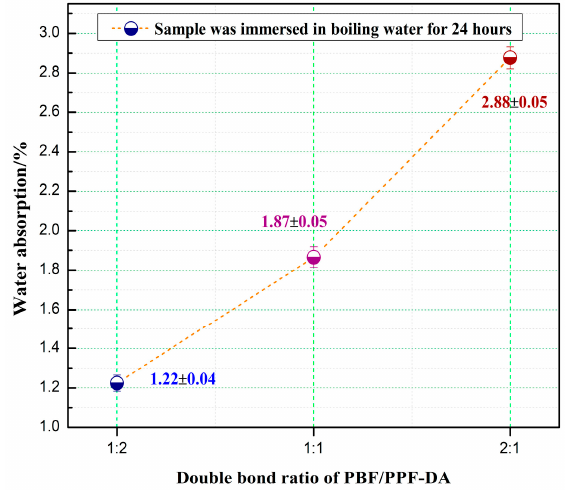
Figure 8. The water absorption ratio of the PBF/PPF-DA polymer networks with double-bond ratios 0.5, 1, and 2 (error bars represent mean ± SD for n = 3).